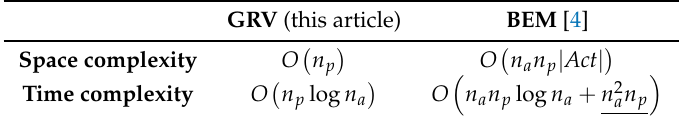
Table 2. Space and time complexity of the GRV algorithm and the BEM